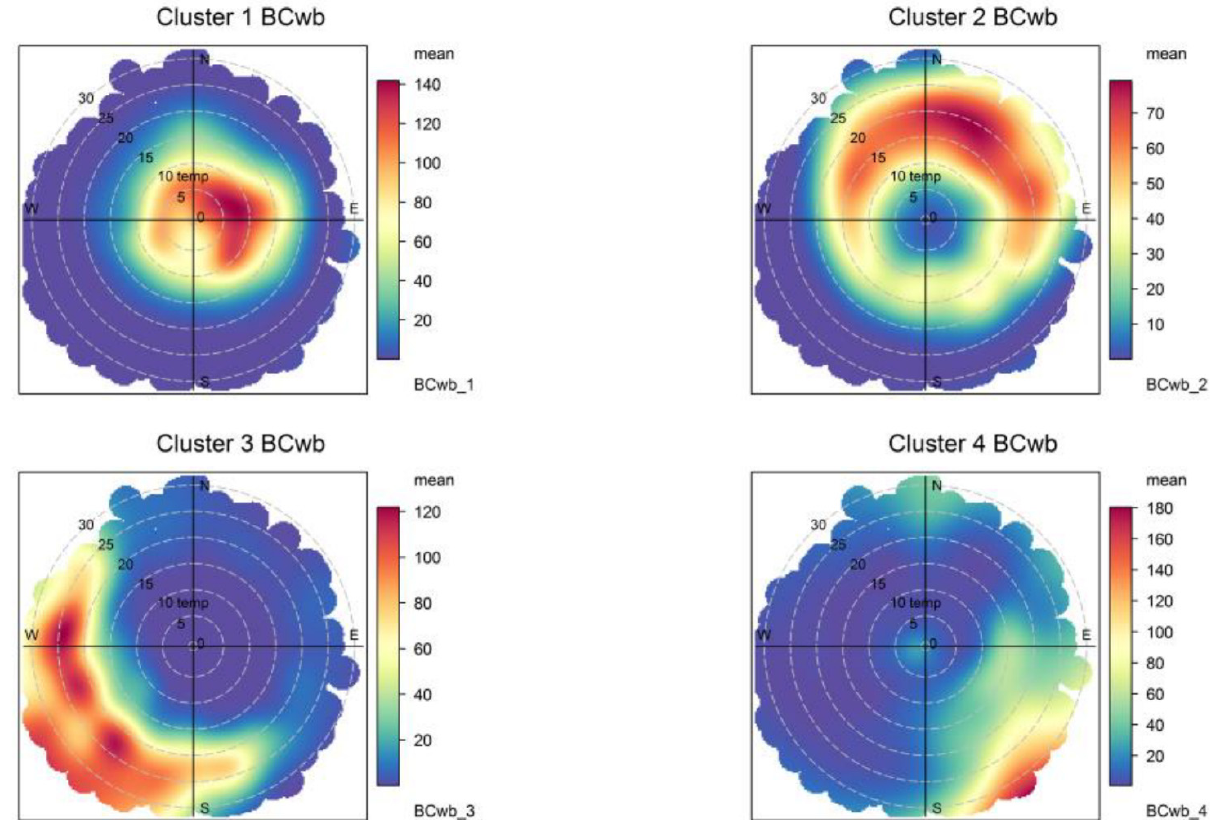
Figure A5. Bivariate plot of hourly BC ff contributions, 2020 campaign, using pressure instead of wind speed.